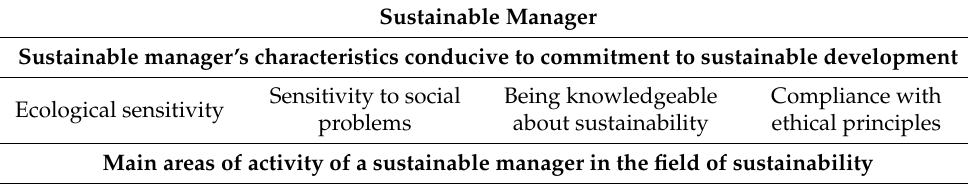
Table 1. Characteristics and main areas of manager’s activity in the area of sustainability. Sustainable